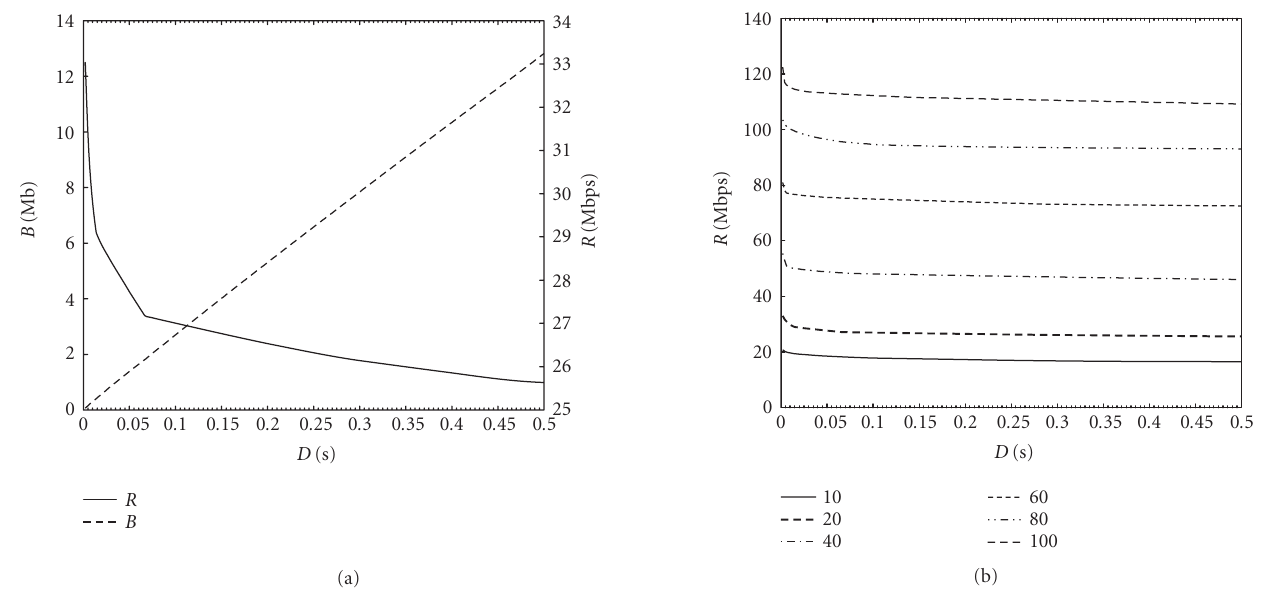
Figure 6: (a) Dimensioning for dynamic tra ffi c (o ff ered load 20Mbps), (b) R for di ff erent aggregates.